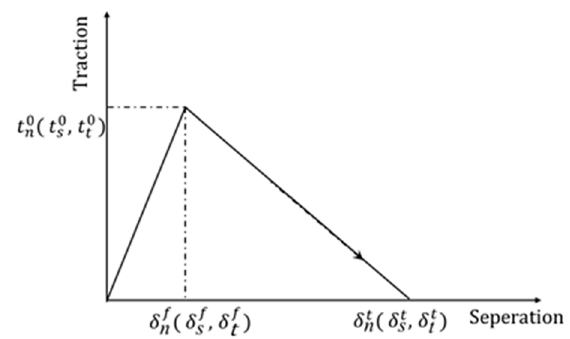
Figure 3. Quadratic nominal stress traction and separation law.